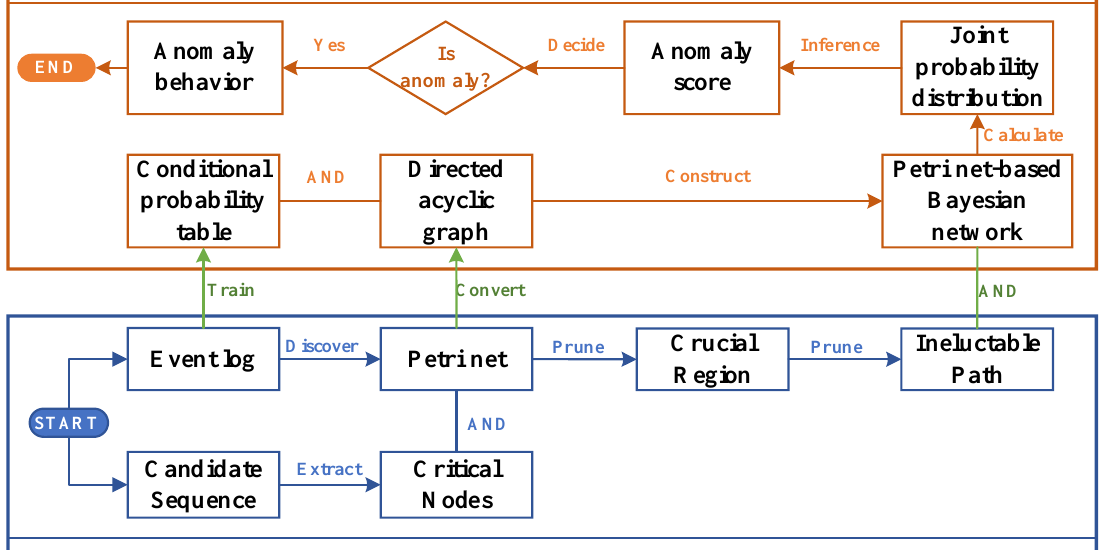
Figure 1. Process of Petri net architecture Bayesian network for anomaly detection.